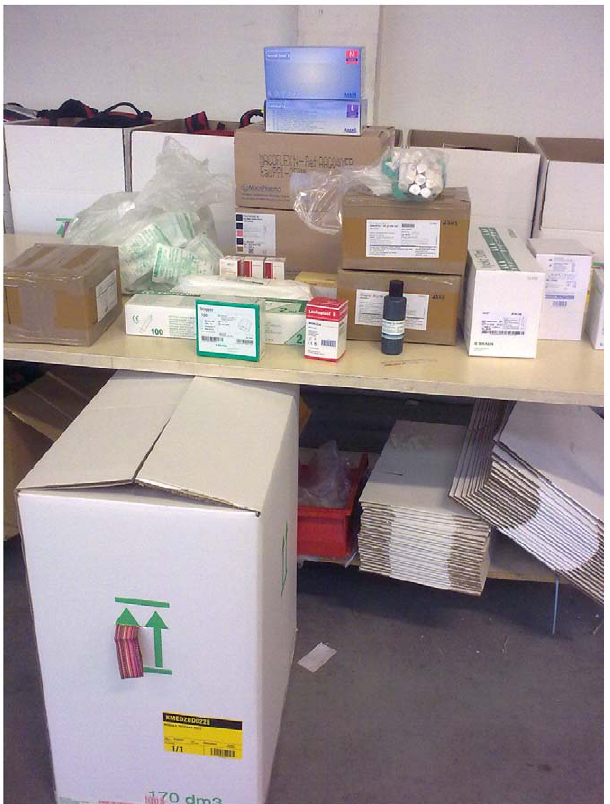
Figure 1. Preparation of a nifurtimox-eflornithine combination therapy (NECT) kit at MSF-Logistique, Me´rignac, France. Photo credit: V. Carlier/MSF-Logistique.